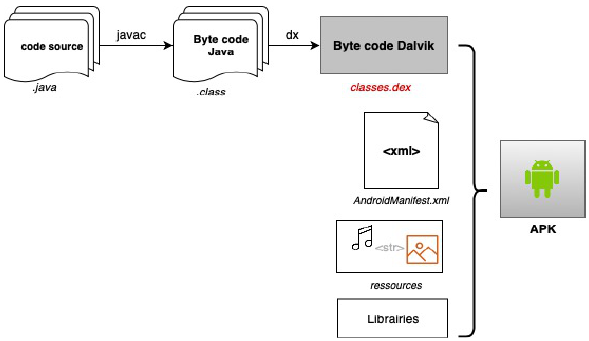
Figure 1. Compilation steps of an Android